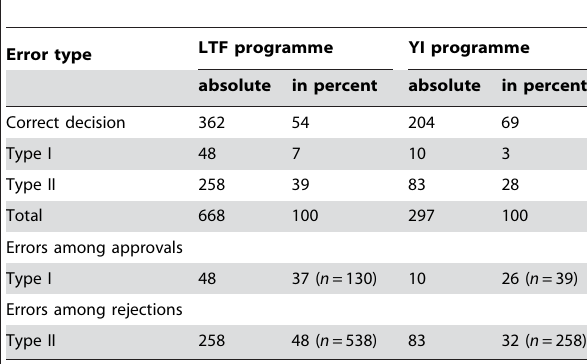
Table 6. Proportions of type I and type II errors in the decisions of the EMBO peer review for the LTF and YI programmes.